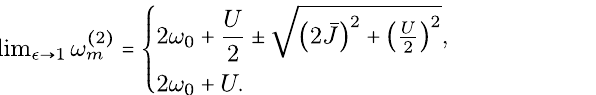
10 dimers, leading =